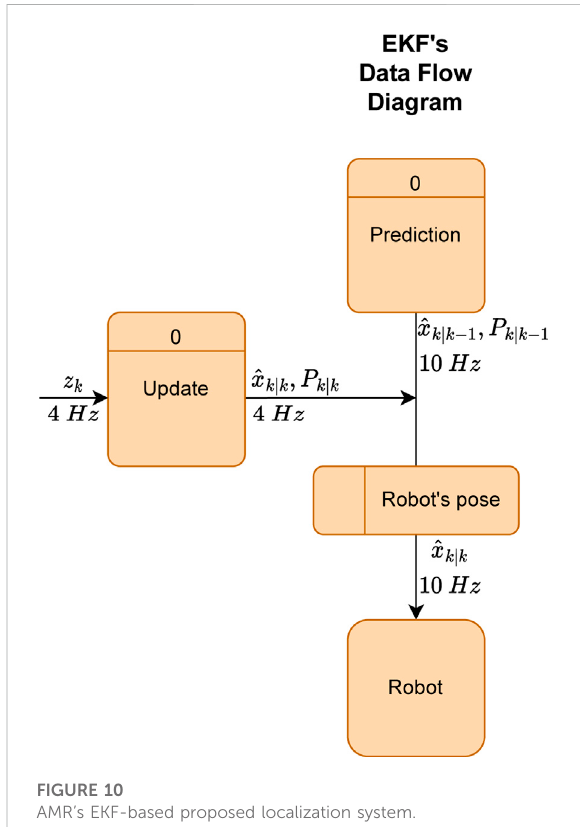
FIGURE 10 AMR ’ s EKF-based proposed localization